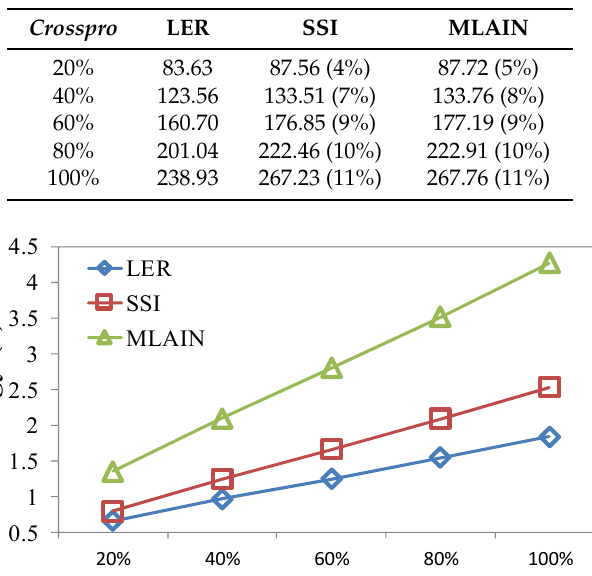
LER SSI MLAIN Figure 10. Average energy consumption for changing WinLengthRatio values. 4.2.3. Impact of θ In the third experimental result, we evaluate the impact of θ with values of 2.1, 2.3, 2.5, 2.7, and 2.9. Figure 11 shows the average access time. As the value of θ increases, the access probabilities of spatial objects become skewed. That is, a few spatial objects in the hot cells with high access probability appear more frequently in the broadcast cycle. This leads to a reduction in the average access time. In Figure 11, as the value of θ increases, the average access times of the three methods decrease slightly, except for those of MLAIN and SSI , for which the value of θ increases from 2.1 to 2.3. Moreover, the access times of MLAIN are much longer than those of LER and SSI . In MLAIN , spatial objects are partitioned into two groups: hot and normal. All the spatial objects in the hot group appear many times at a relatively high broadcast frequency in a broadcast cycle. Therefore, the number of spatial objects in this hot group has a strong effect on the size of the broadcast cycle, which determines the access time. On the other hand, in both LER and SSI , the spatial objects are partitioned into a few groups by the BD method [9], instead of just two groups. Consequently, the